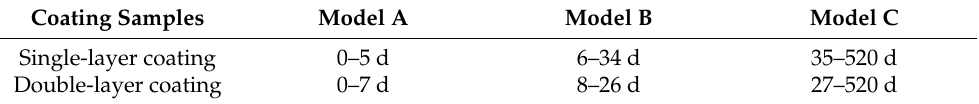
Figure 9. Equivalent circuit models for the coating samples in different immersion stages: ( a ) Model A; ( b ) Model B; ( c ) Model C. Table 1. Equivalent circuit models for the coating samples in different immersion stages.